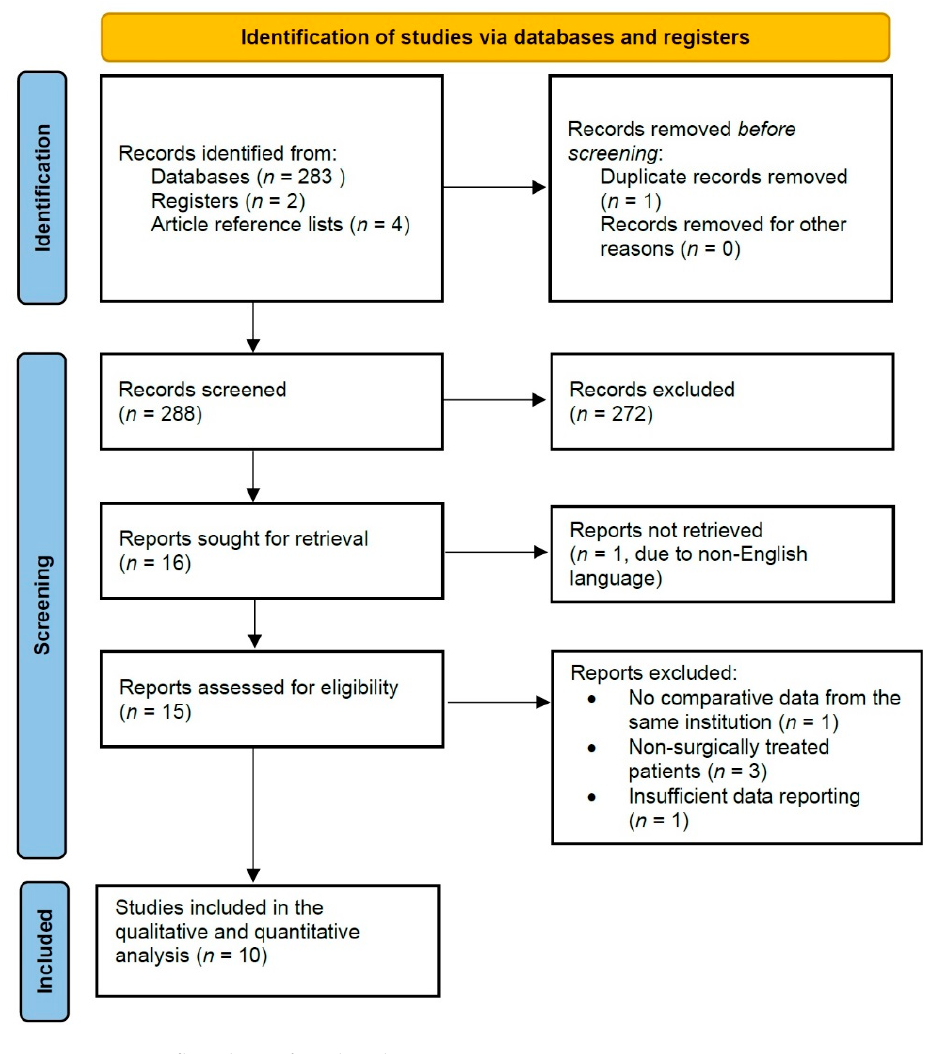
Figure 1. Prisma flowchart of study selection. When analyzed for methodological quality, eight studies had an NOS score of 7 to 9 and were deemed of high methodological quality, and two studies had a score of 5 or 6 and were deemed of mediocre methodological quality. The median score of the obtained NOS scores was 7.5 (Table